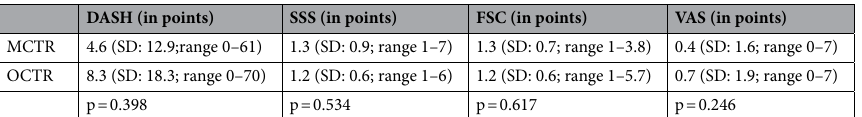
Table 1. Functional differences of MCTR versus OCTR. Functional results are listed at mean. All scores were statistically not significant in comparison. DASH disabilities of arm, shoulder and hand score, SSS symptom severity scale, FSC functional status scale, VAS visual analogue scale, MCTR mini-open carpal tunnel release, OCTR Open carpal tunnel release.